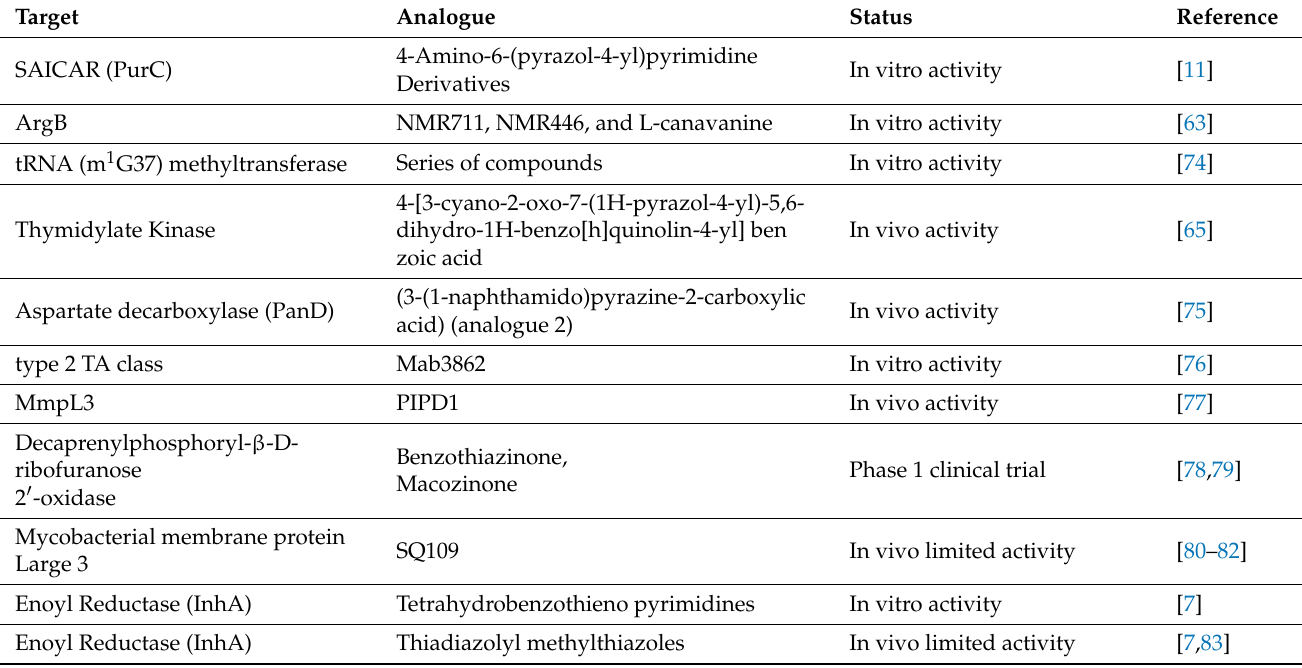
Table 1. Tested analogues, target compounds, and their